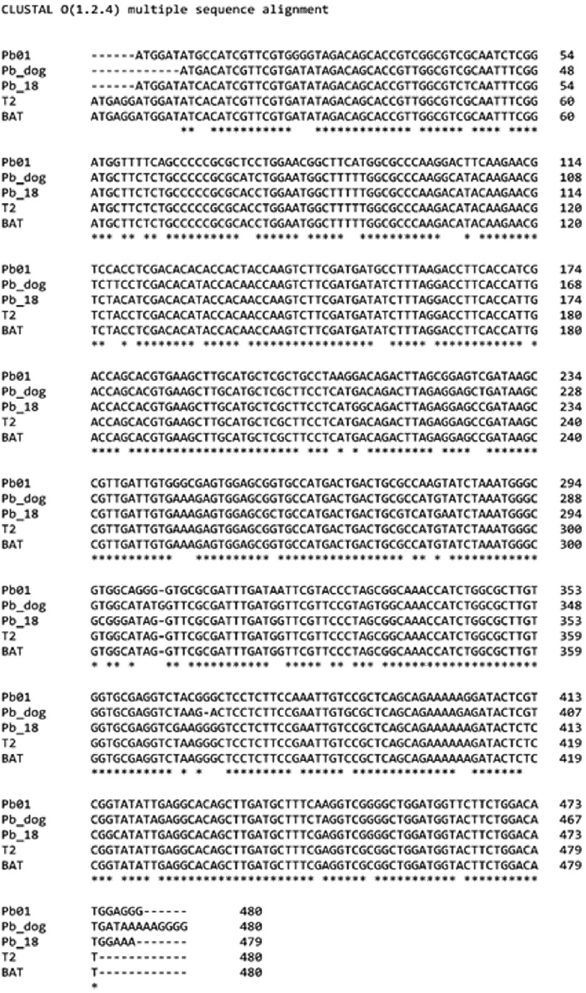
Figure 2 - Alignment of gp43 exon 2 loci nucleotide sequences from Paracoccidioides spp. reference strains and BAT clinical isolate. The identity between BAT isolate and T2-EPM54 ( P. restrepiensis – PS3 ref- erence strain) was observed, as well as genetic proximity with Pb 18 ( P. brasiliensis sensu stricto – S1b) but with greater phylogenetic distance from Pb dog-EPM194 ( P. americana – PS2) and Pb 01 ( P. lutzii ). *: repre- sents similar nucleotides in the analyzed sequences.